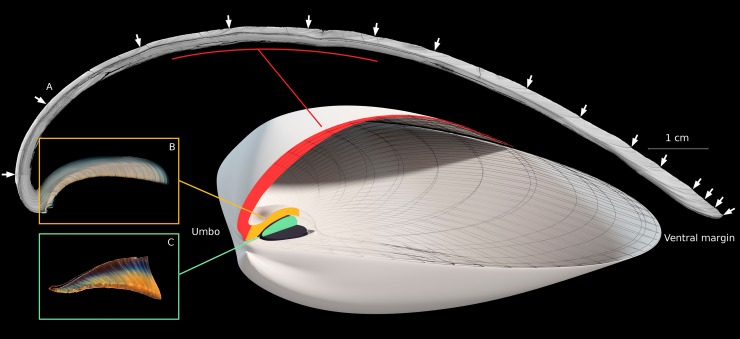
3D model of the general structure of the shell and hinge ligament of S. solidissima.The outer shell layer (A—red) and chondrophore (B—yellow) of the right valve, as well as the right half of the hinge ligament (C—green), are sectioned along the axis of maximal growth (from the umbo to the ventral margin). White arrows are placed at the locations of annual lines in the outer shell layer. These three structures are associated with the corresponding photomosaic, all of which were obtained from the same individual.